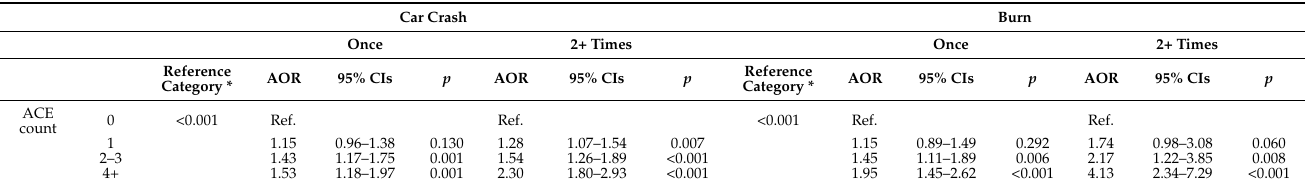
Table 3. Multinomial logistic regression analysis: relationship between ACE count and frequency of injury